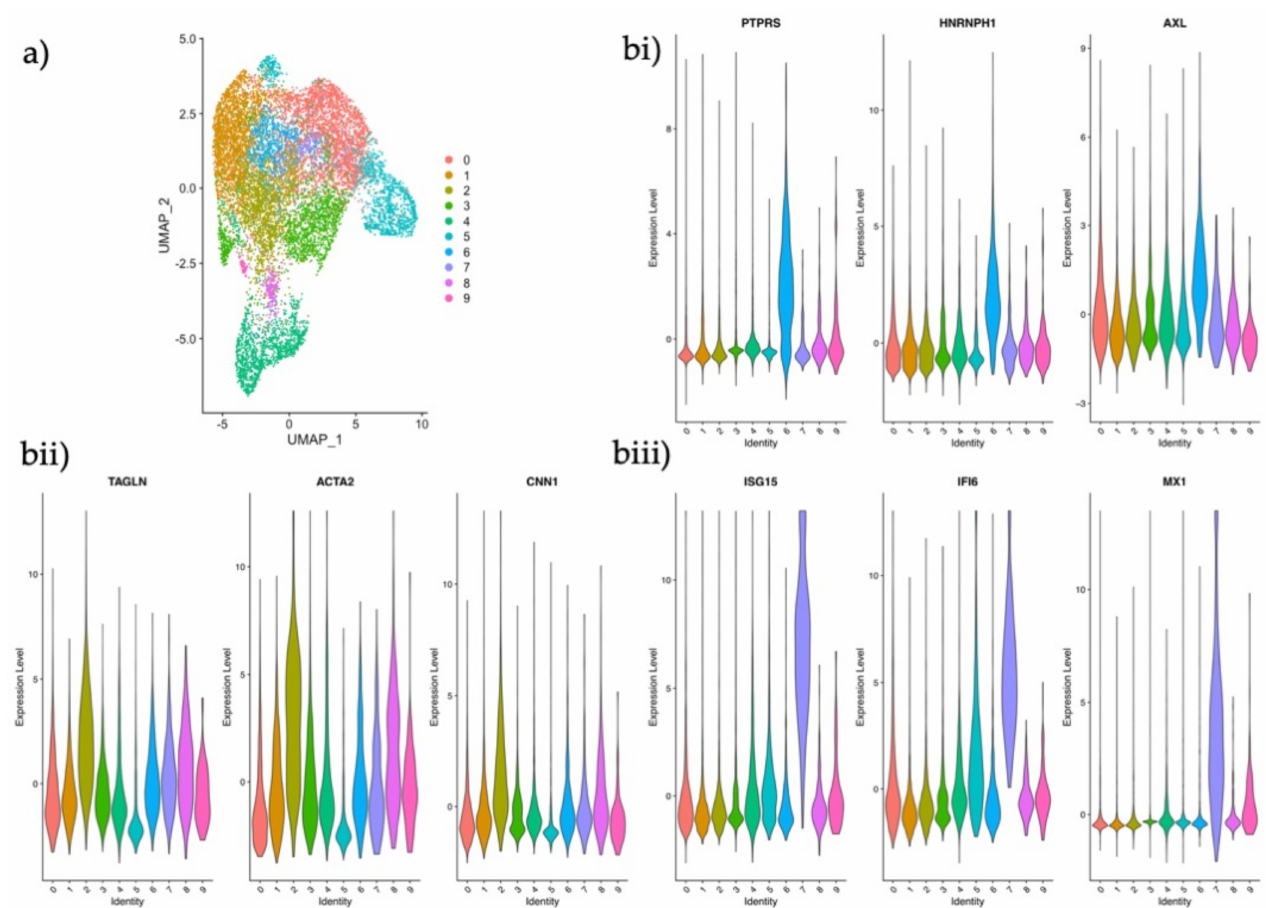
Figure 5. Analysis and identification of endometrial stromal subtypes in the maternal-fetal interface. ( a ) UMAP plot of scRNA-seq data of the maternal CD45 − decidual fraction from the maternal-fetal interface displaying ten clusters using the same parameters applied in our dataset. ( b ) Violin plots of log2 normalized counts showing marker gene expression for each population. ( i ) CTNNB1+ epithelial regulator; PTPRS, HNRNPH1 and AXL ( ii ) ACTA2+ activated fibroblast; TAGNLN, ACTA2 and CNN1 ( iii ) ISG15+ innate immunity stromal subtype; ISG15 , IFI6 and MX1